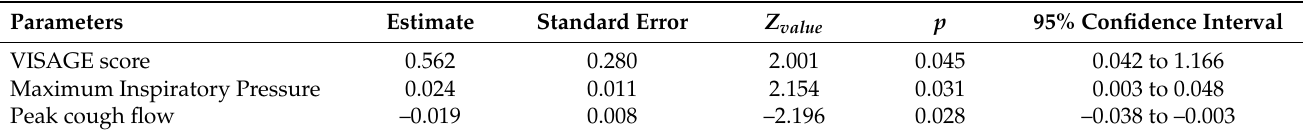
Table 3. Estimates of parameters evaluated in the linear regression model.